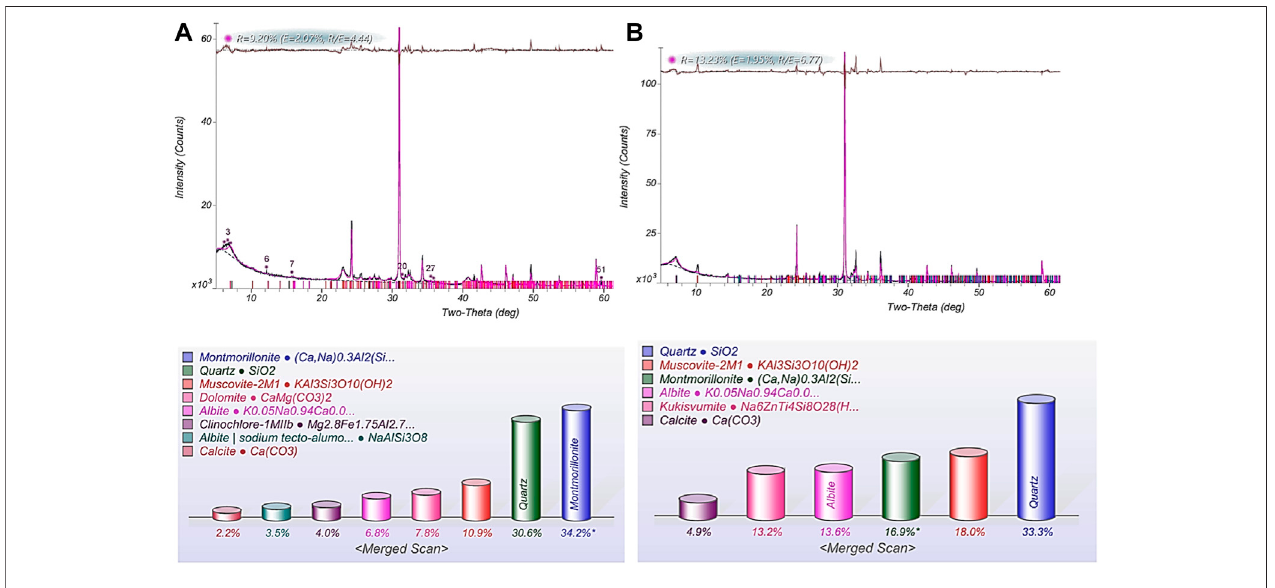
FIGURE 1 | XRD scans of (A) elastic silt; (B) clayey